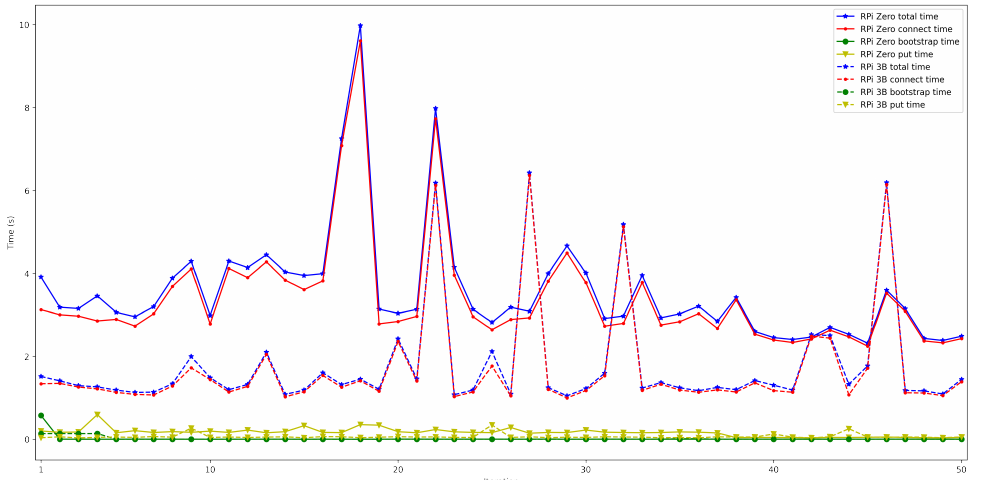
Figure 17. Latency when using Raspberry Pi Zero/3B+ gateways for 100 peers connected to the bootstrap